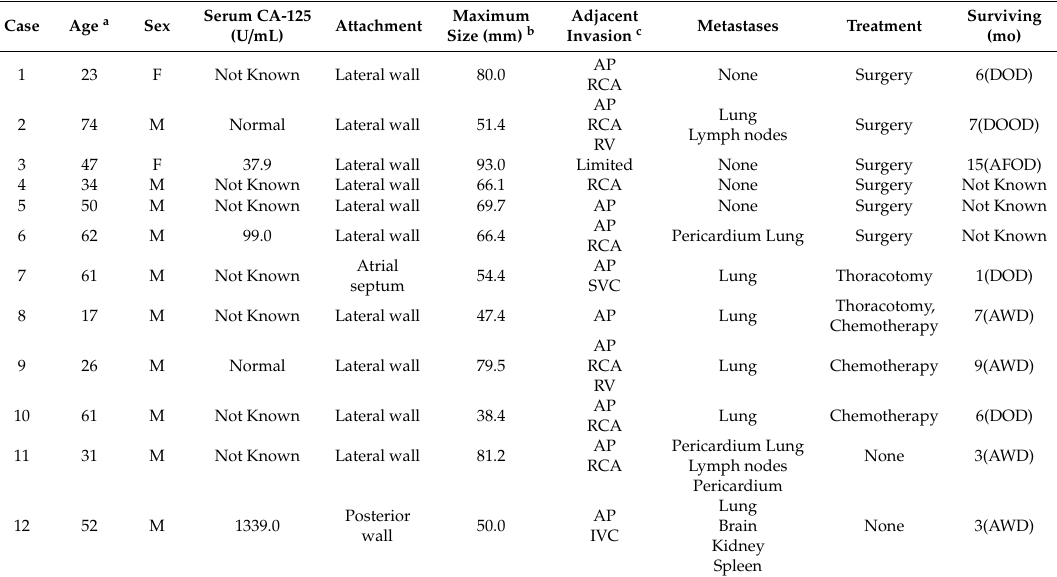
Table 1. Clinical and imaging features of primary cardiac